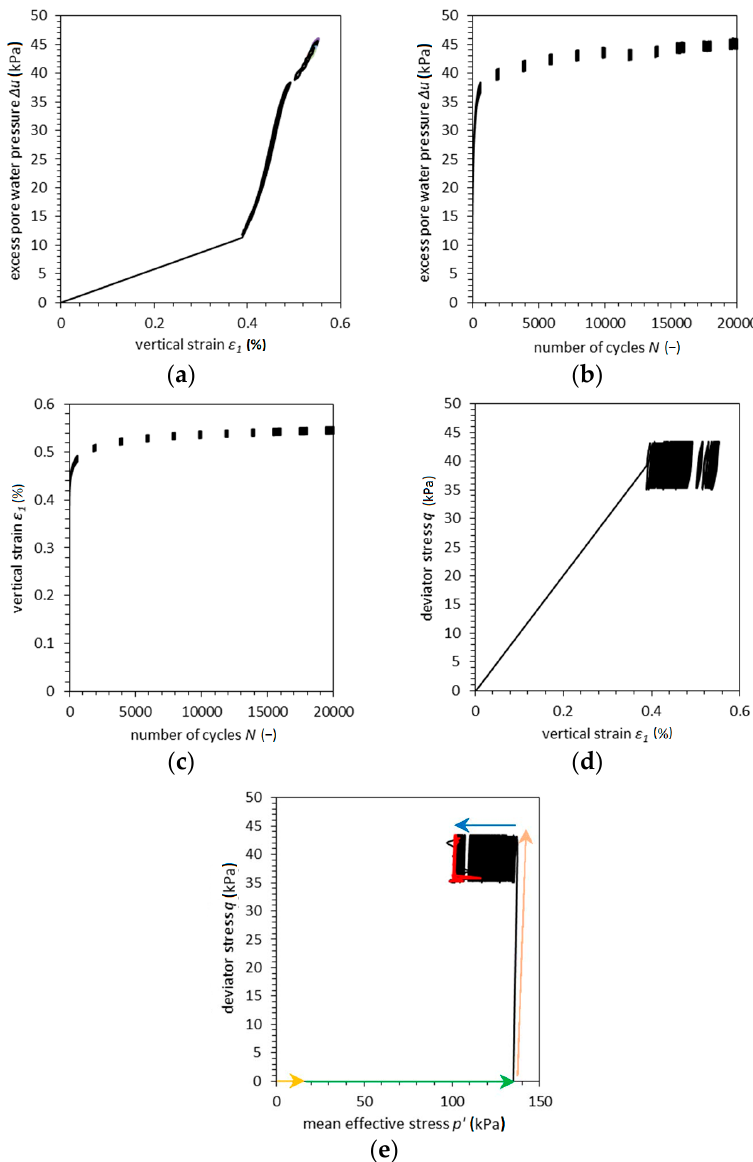
Figure 4. Results of the cyclic triaxial test for sandy silty clay under confining pressure of 135 kPa and under the isotropic consolidation, initial void ratio e 0 = 0.412—sample 1.3: ( a ) Excess pore water pressure versus vertical strain characteristic, ( b ) excess pore water pressure characteristic versus number of cycles, ( c ) vertical strain characteristic versus number of cycle, ( d ) deviator stress–vertical strain relationship, and ( e ) the deviator stress–mean e ff ective stress relationship (red color—last 10 cycles; arrow color—violet: Saturation phase, green: Consolidation phase, orange: First cycle of cyclic loading, blue: Cyclic loading